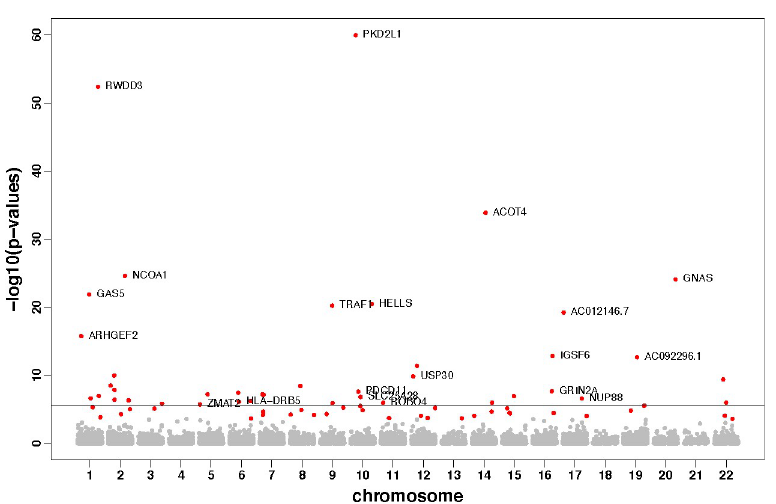
Fig 4. Manhattan plot of VC-TWAS using IGAP summary data with BGW cis- and trans- eQTL weights. Significant genes with FDR < 0.05 are colored.